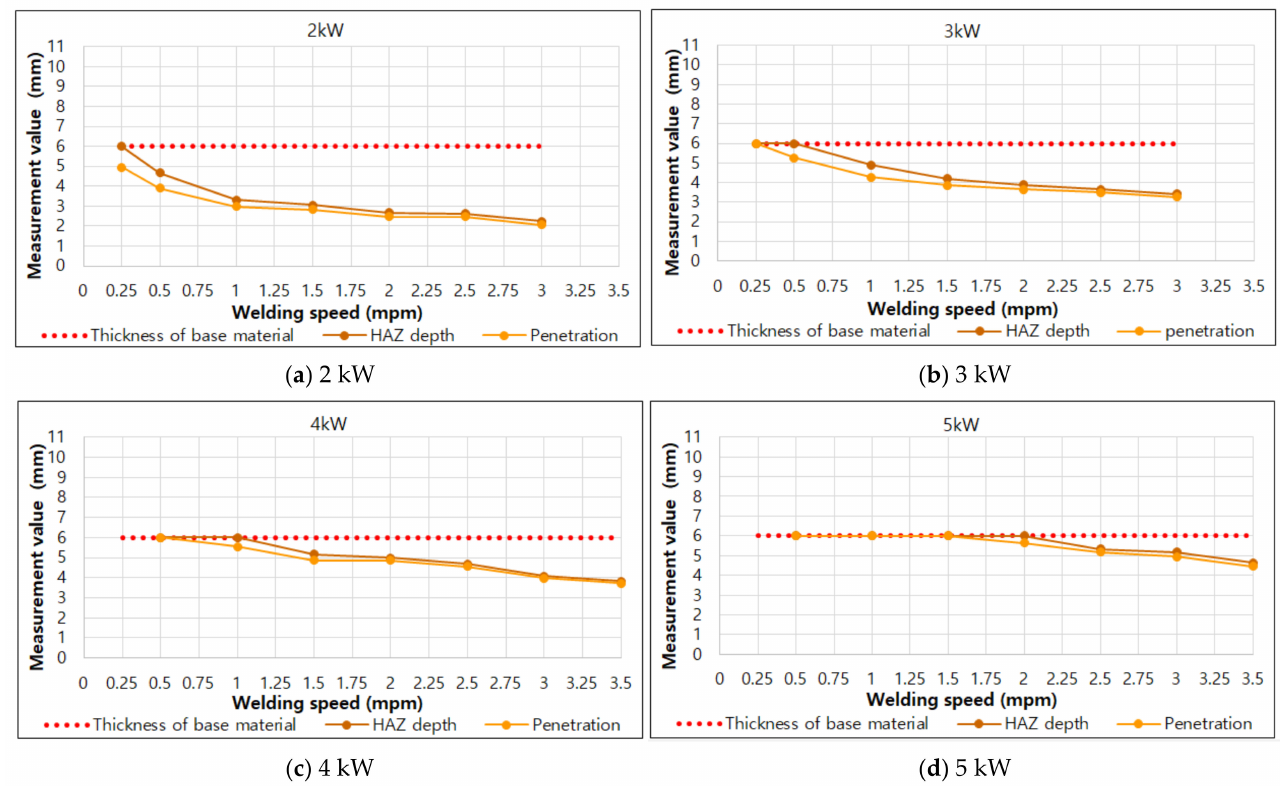
Figure 6. HAZ depth and penetration according to welding speed under each laser output